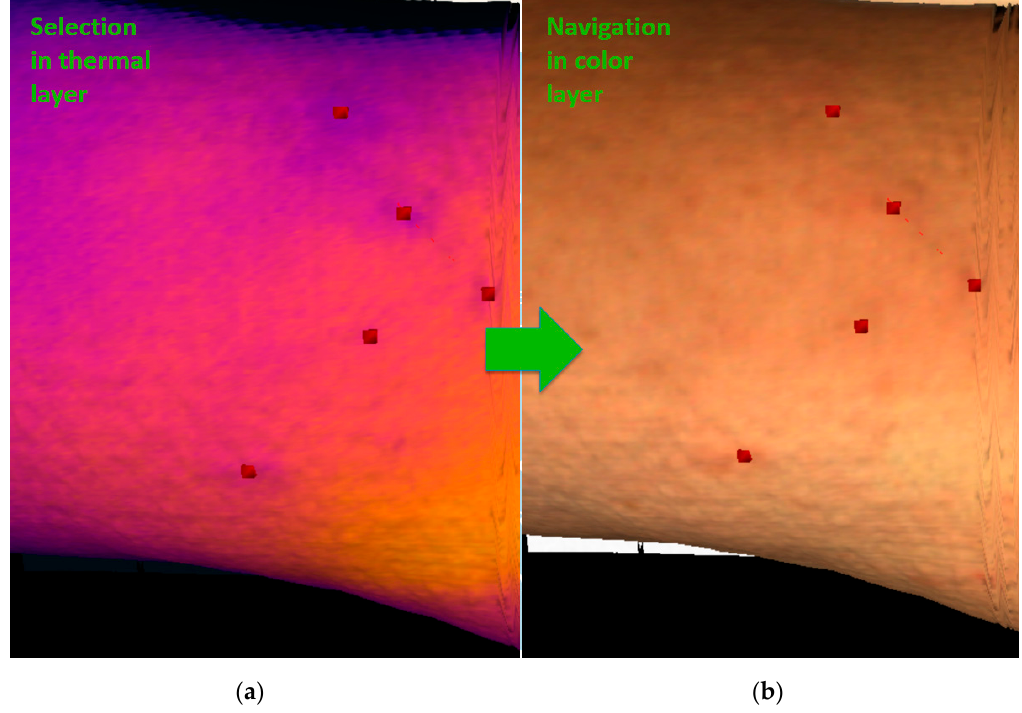
Figure 8. Resolving the exact localization problem: ( a ) the potentially problematic spots are highlighted in the thermal layer of the 3D model; ( b ) the selected points are localized in the color layer.